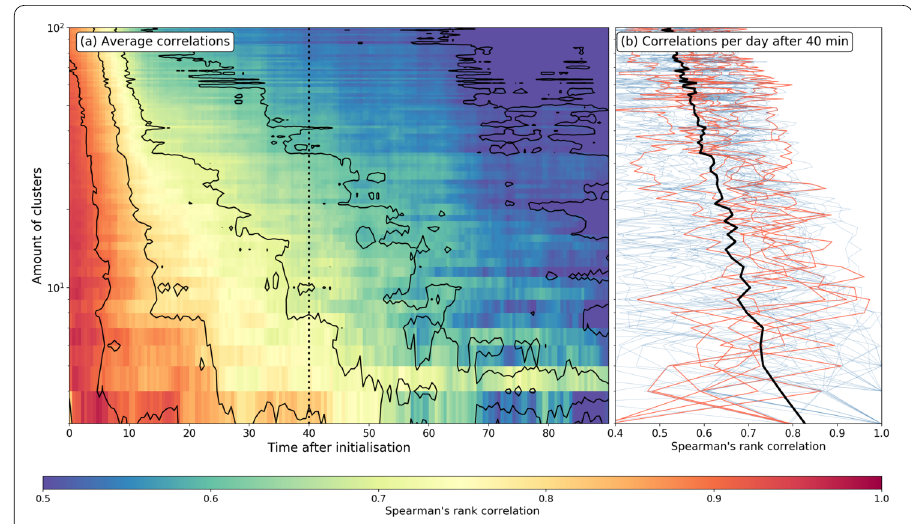
Figure 6 Panel ( a ): Average Spearman’s rank correlation coefficients in colours averaged over the 50 disrupted days, for various values of K (vertical) and time points after model initialisation (horizontal, in minutes). The contours indicate the levels 0.5, 0.6, 0.7, 0.8 and 0.9. The vertical dashed line corresponds to 40 minutes after initialisation, which is used in the other panel. Panel ( b ): Spearman’s rank correlation coefficients at 40 min after initialisation. Individual days are split into days that have their maximum at values of K < 9 (in blue) and those that have their optimum performance at values of K ≥ 9 (in red). The black line indicates the 50-day